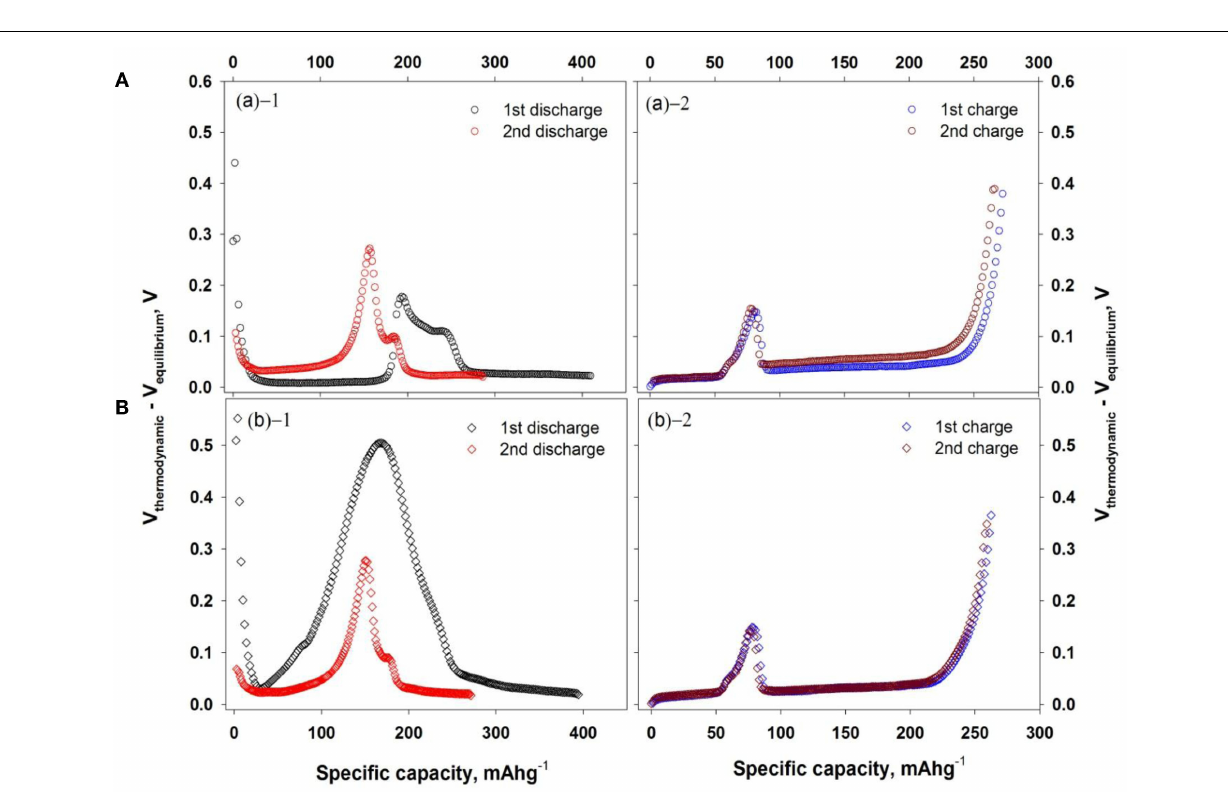
as first charge–discharge cycle showed definite changes between LTO- and Al 2 O 3 -coated LTO electrodes. For bare LTO, there were two semi-circles, which were related to the charge transfer resistance and the SEI layer growth, respectively. On the other